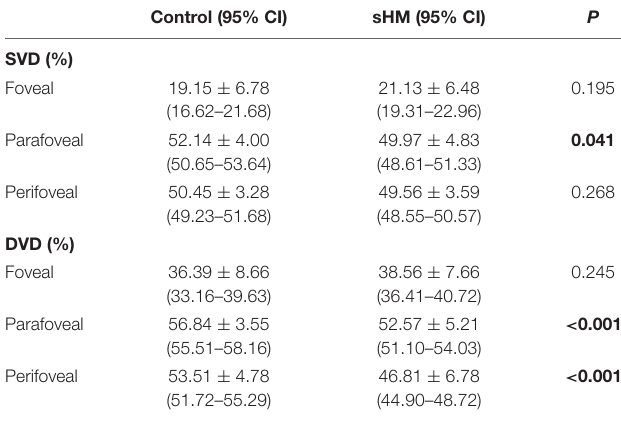
TABLE 2 | Retinal vascular density in the sHM and control